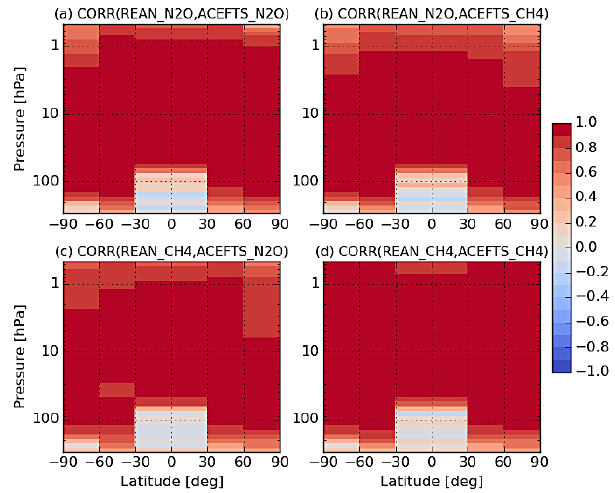
Figure 12. Correlation coefficients between (a) ACE–FTS N 2 O and REAN N 2 O, (b) ACE–FTS CH 4 and REAN N 2 O, (c) ACE–FTS CH 4 and REAN N 2 O, (d) ACE–FTS CH 4 and REAN CH 4 as a function of latitude and pressure for the period October 2007–April